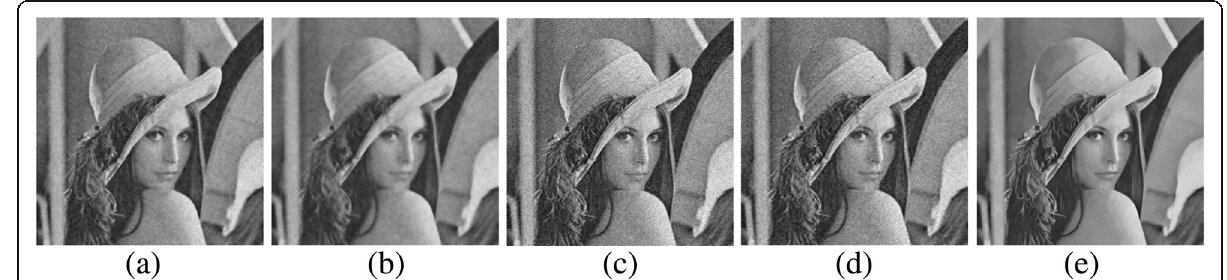
Fig. 2 Visual comparisons of denoising results on Lena image corrupted by additive white Gaussian noise with standard deviation 30: a Wiener filtering [16] (PSNR = 27.81 dB; SSIM = 0.707); b Bilateral filtering [10] (PSNR = 27.88 dB; SSIM = 0.712); c PCA method [87] (PSNR = 26.68 dB; SSIM = 0.596); d Wavelet transform domain method [89] (PSNR = 21.74 dB; SSIM = 0.316); e Collaborative filtering: BM3D [55] (PSNR = 31.26 dB; SSIM =